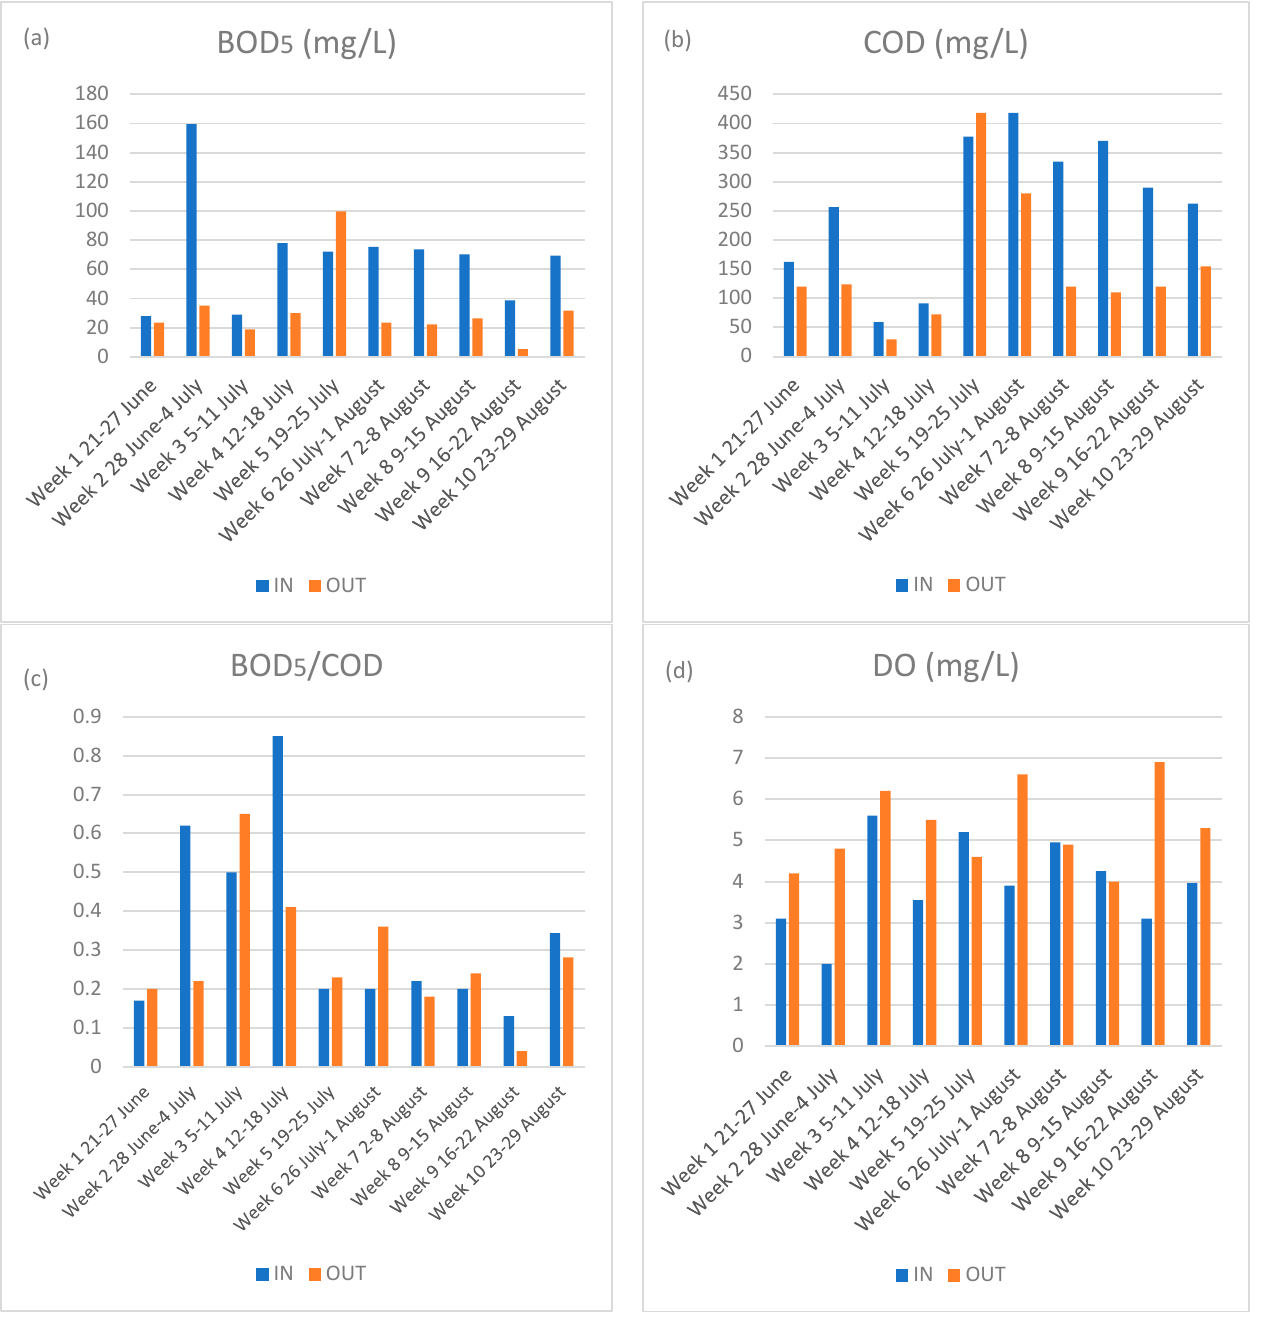
Figure 5. Time course evolution of biological oxygen demand ( a ), chemical oxygen demand ( b ), ratio of BOD5/COD ( c ), and dissolved oxygen ( d ).